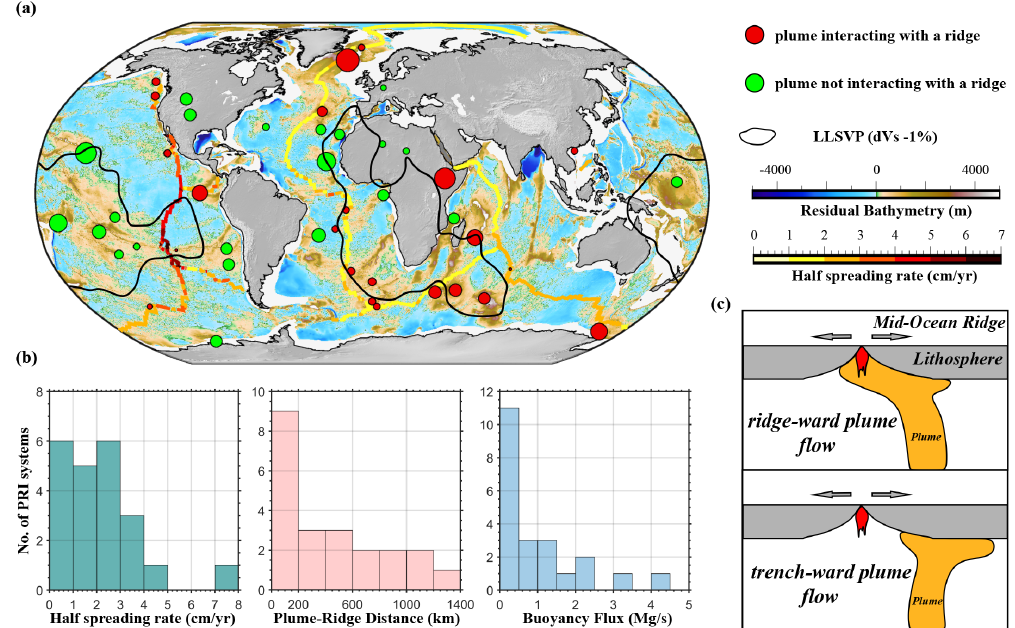
Figure 1. Global plume–ridge interaction systems. (a) Global distribution of mid-ocean ridges and mantle plumes. Residual bathymetry of the ocean basins comes from Straume et al. (2019). Mid-ocean ridges are painted in solid colored lines corresponding to half-spreading rate. Plumes not interacting with a ridge are shown by green circles, and hotspots linked to ridges are in red dots (Ito et al., 2003); size refers to the plume buoyancy flux from Hoggard et al. (2020). Black lines denote the regions of two LLSVPs (large low-shear velocity provinces) under South Africa and the Pacific Ocean (Torsvik et al., 2006). (b) Histograms of influential factors of plume–ridge interaction systems. Half the spreading rate and plume–ridge distance are taken from GPlates (Müller et al., 2016; Whittaker et al., 2015). Plume–ridge interaction systems link to slow-spreading ridges, small mantle plumes and short plume–ridge distances. (c) Sketches of ridgeward (top panel) and plate-drag plume flow (bottom panel) mode proposed,